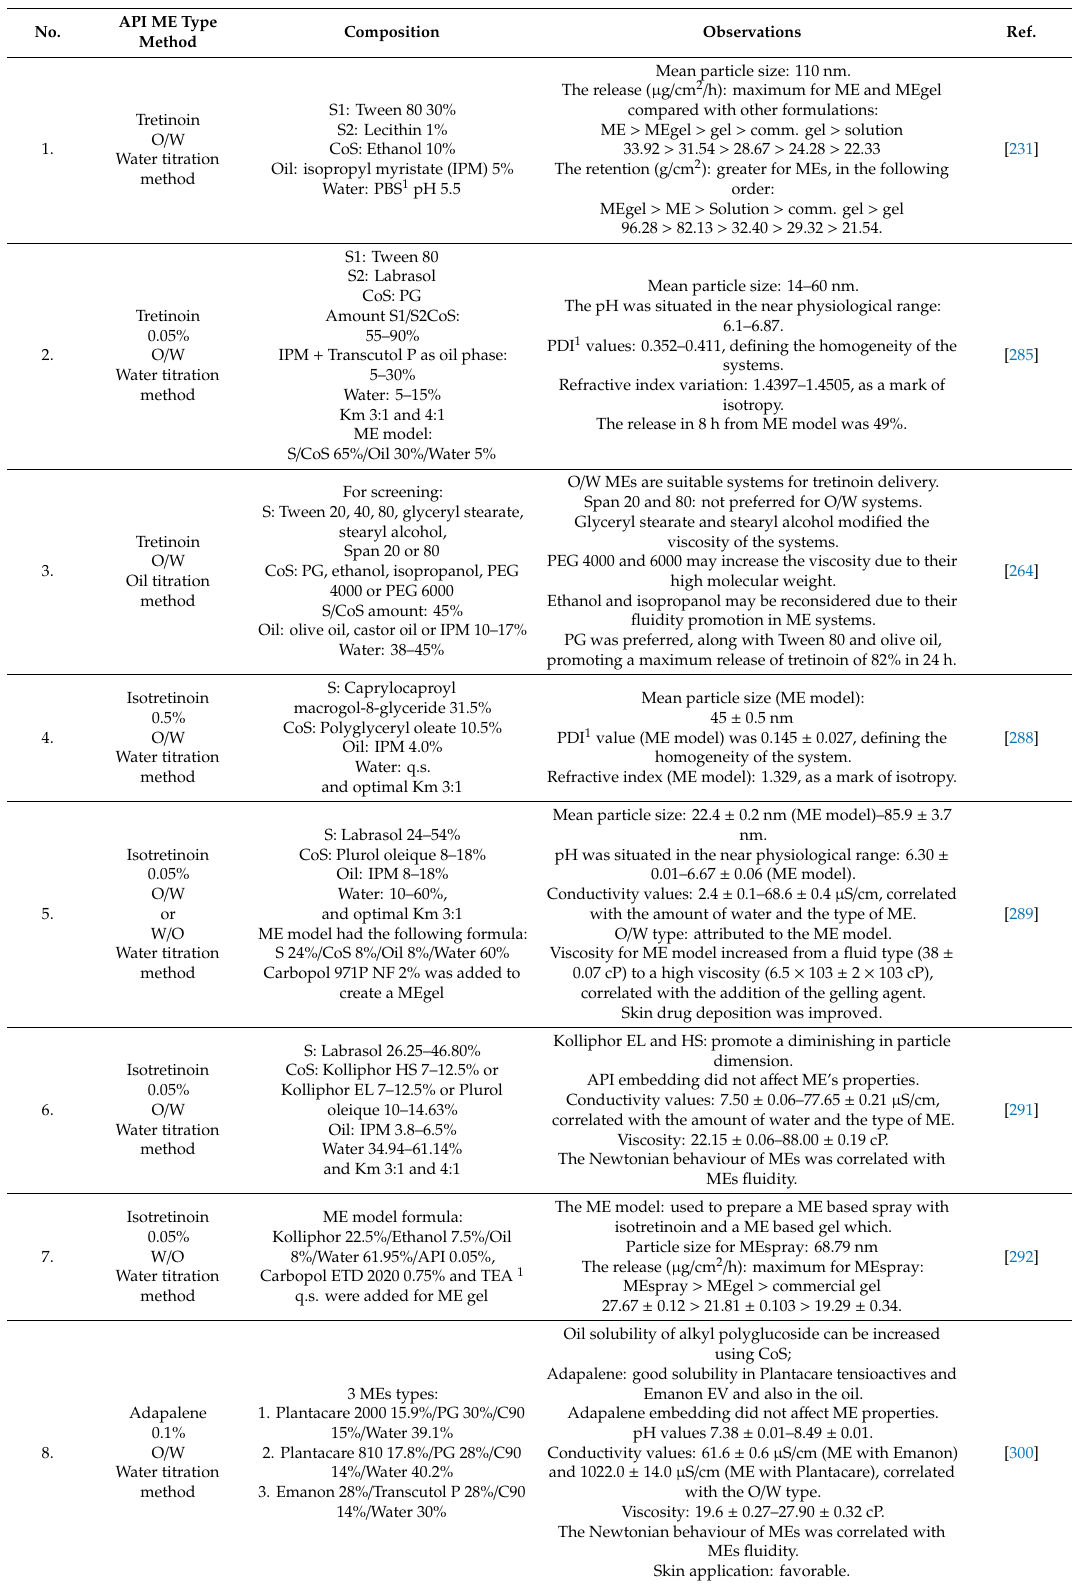
Table 4. Valuable results of experimental studies considering anti-acne microemulsion